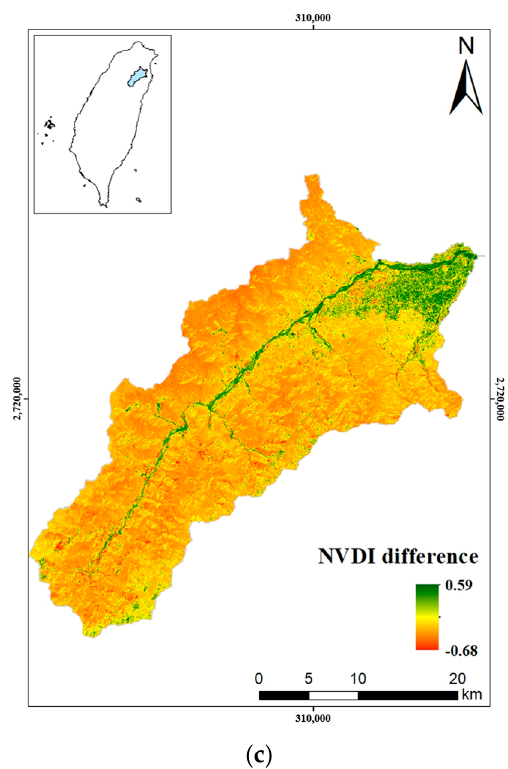
Figure 6. NDVI di ff erence between di ff erent periods in Lanyang River Basin. ( a ) NDVI di ff erence in Figure 6. NDVI difference between different periods in Lanyang River Basin. ( a ) NDVI difference in Lanyang River Basin during 1978 to 1993. ( b ) NDVI di ff erence in Lanyang River Basin during 1993 to Lanyang River Basin during 1978 to 1993. ( b ) NDVI difference in Lanyang River Basin during 1993 to 2004. ( c ) NDVI di ff erence in Lanyang River Basin during 2004 to 2004. ( c ) NDVI difference in Lanyang River Basin during 2004 to 2018.